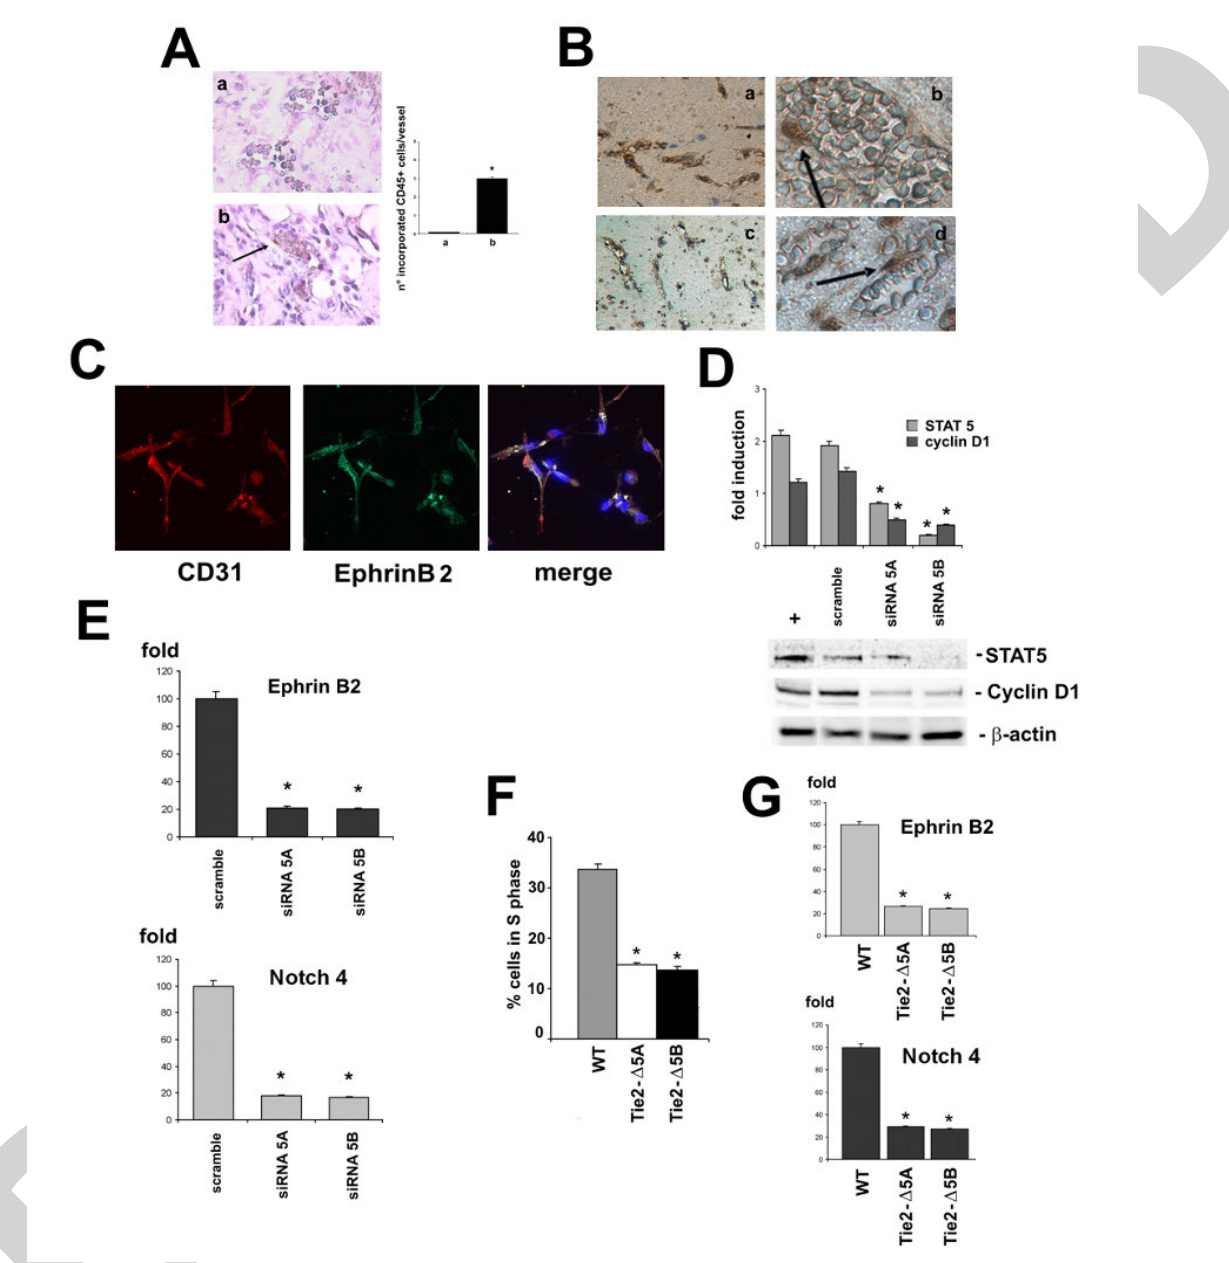
FIGURE 1. IL-3 promotes expansion of hemopoietic-derived CD45+ angiogenic cells and their arterial commitment via STAT5. (A) Tumor EC, added to Matrigel and injected into SCID mice, form functional neovessels (panel a). Prelabeled IL- 3–expanded cells, injected in the tail vein, are incorporated in tumor neovessels (panel b). Black arrows indicate the incorporated CD45+ cells. The number of incorporated cells per vessel is reported in the histogram. (B) IL-3–cultured CD45+ cells, added to Matrigel and injected into SCID mice, are able to form functional vessels, after 15 days (panels b,d). No functional vessels could be detected early after injection (5 days) (panel a,c). Black arrows indicate positive CD45+ cells. (C) Arterial specification is documented by the positive double staining (CD31, red; EphrinB2, green) of IL-3– expanded CD45+ cells. DAPI staining is used as nuclear marker. (D) Depletion of STAT5 in IL-3–expanded CD45+ cells abrogates cyclin D1 expression. (E) STAT5 silencing also prevents arterial specification. (F,G) IL-3–mediated cell-cycle progression and arterial specification of BM-derived CD45+ cells is prevented in Tie-2-transgenic mice expressing dominant-negative STAT5